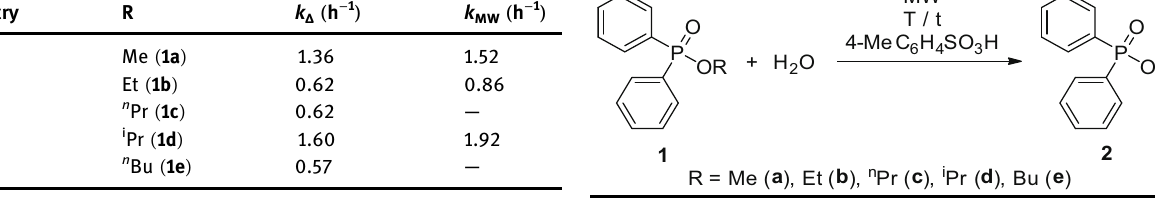
Table 3: MW - assisted hydrolysis of alkyl phenylphosphinates ( 1a – e ) in the presence of PTSA catalyst